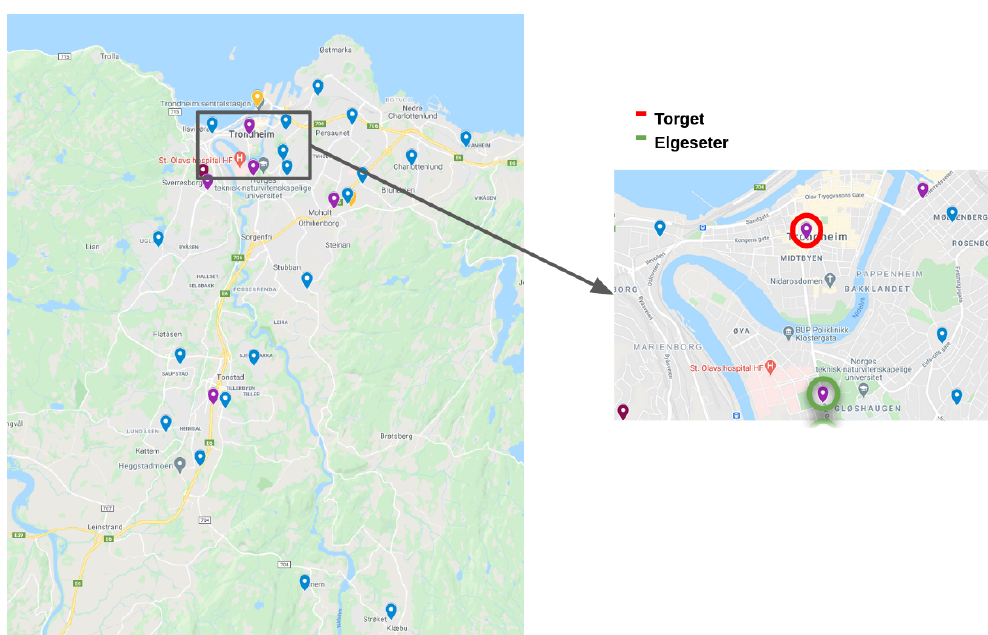
Figure 2. ( Left ): sensor network map ( Blue : deployed low-cost sensors; Yellow : planned low-cost sensors; Purple : NEA network of industrial sensors). ( Right ): highlight of locations where low-cost sensors are co-located with reference sensors.